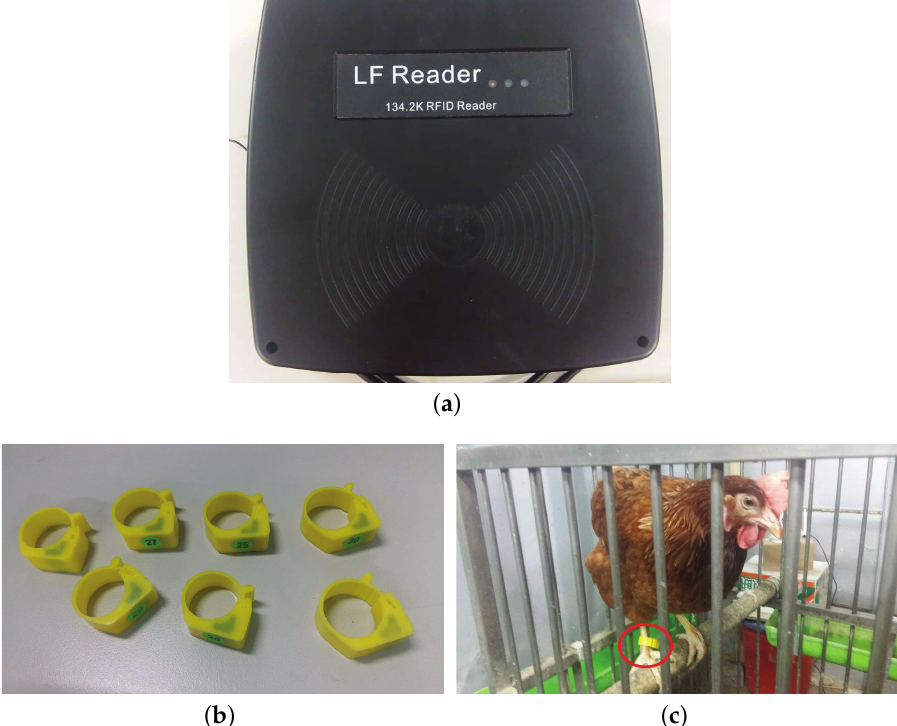
Figure 3. Photos of ( a ) an RFID reader, ( b ) foot ring RFID tags, and ( c ) a hen wears a foot-ring RFID